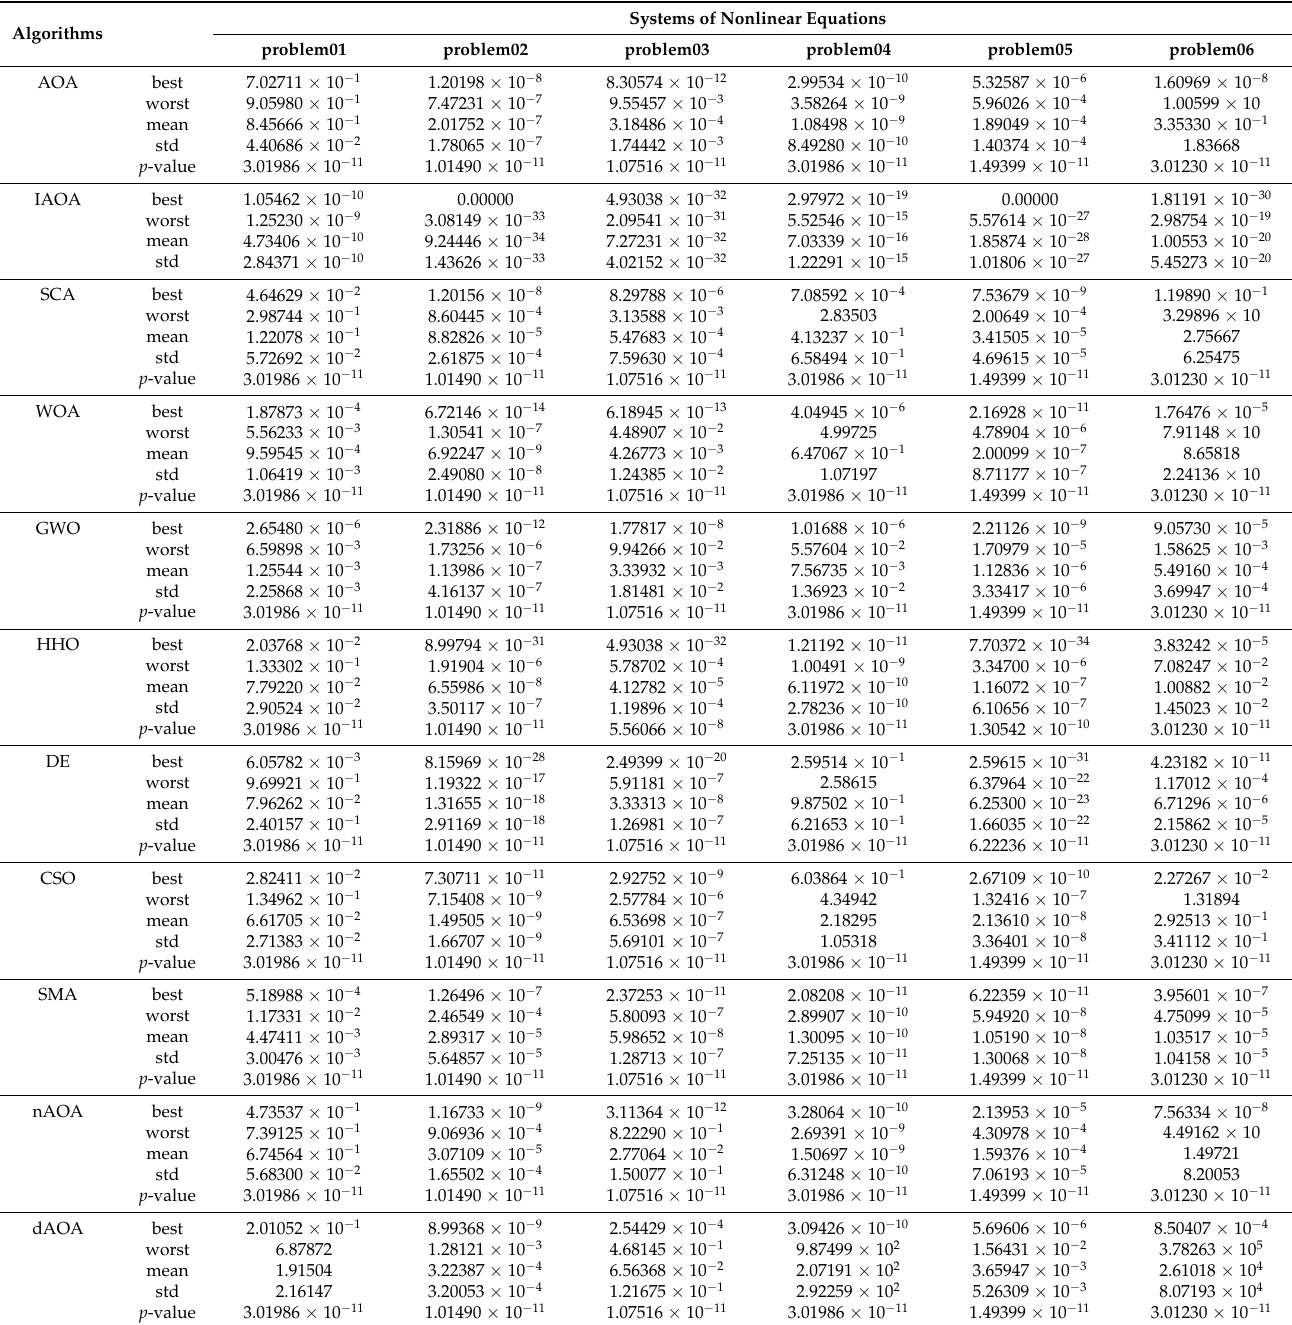
Table 7. Statistical results for the